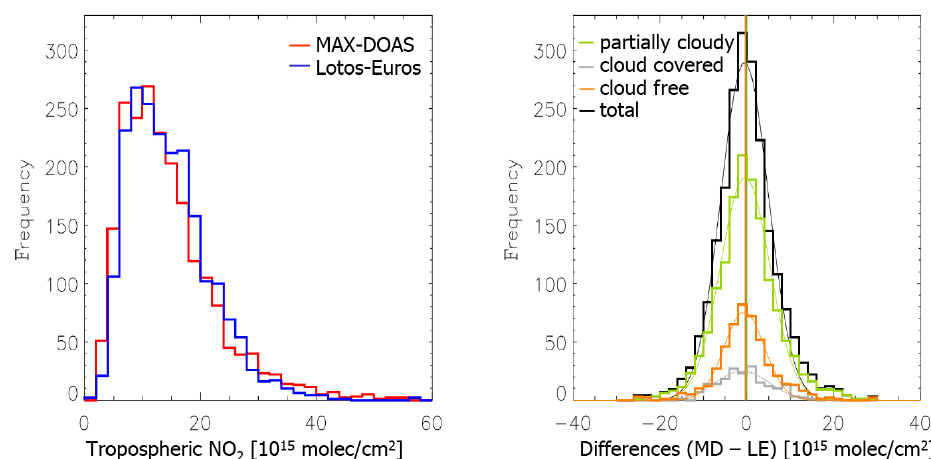
Figure 6. Histogram of 1h averaged tropospheric NO 2 columns observed with MAX-DOAS and of Lotos-Euros (left panel), and a histogram of differences (right panel), subdivided according to cloudiness, as explained in Table 1. The vertical lines indicate the average differences of each subset. Also shown are Gaussian fits to the histogram of differences. See also Table 3.